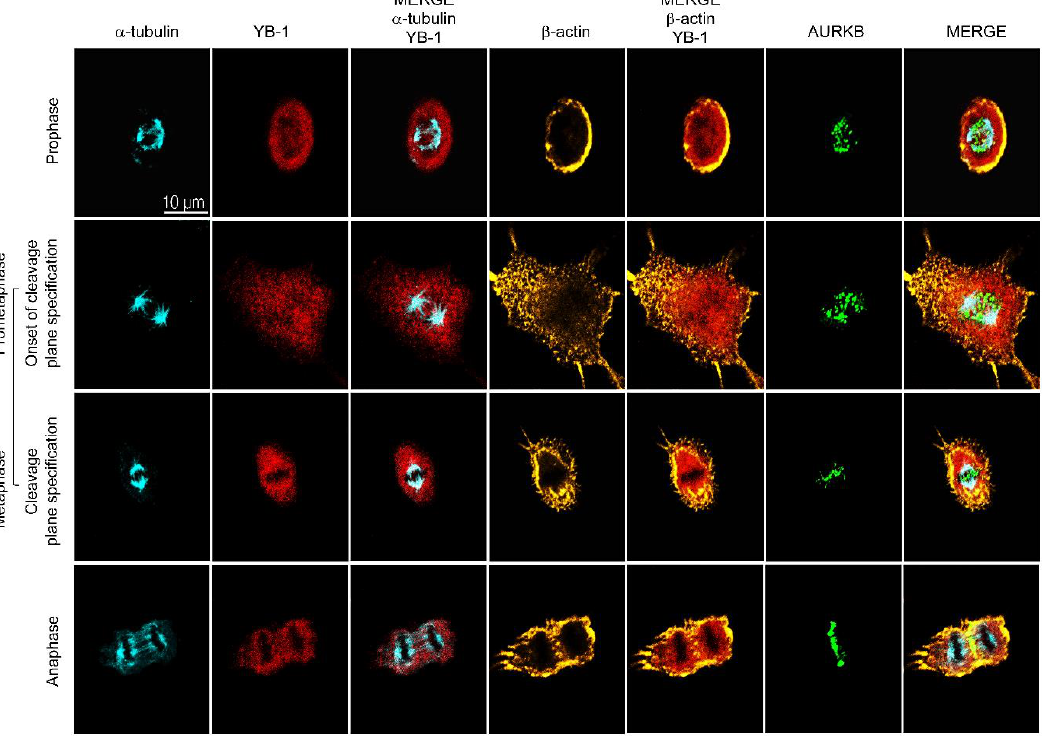
Figure 3. YB-1 is required for formation of the cleavage furrow. Examples of synchronized A549 cells enriched for cytokinesis, immunostained with antibodies against (from left to right) α -tubulin (cyan), YB-1 (red), merge of α -tubulin and YB-1, β -actin (yellow), merge of β -actin and YB-1, AURKB (green) followed by a merged image of all three. Images were acquired using a 60 × oil-immersion